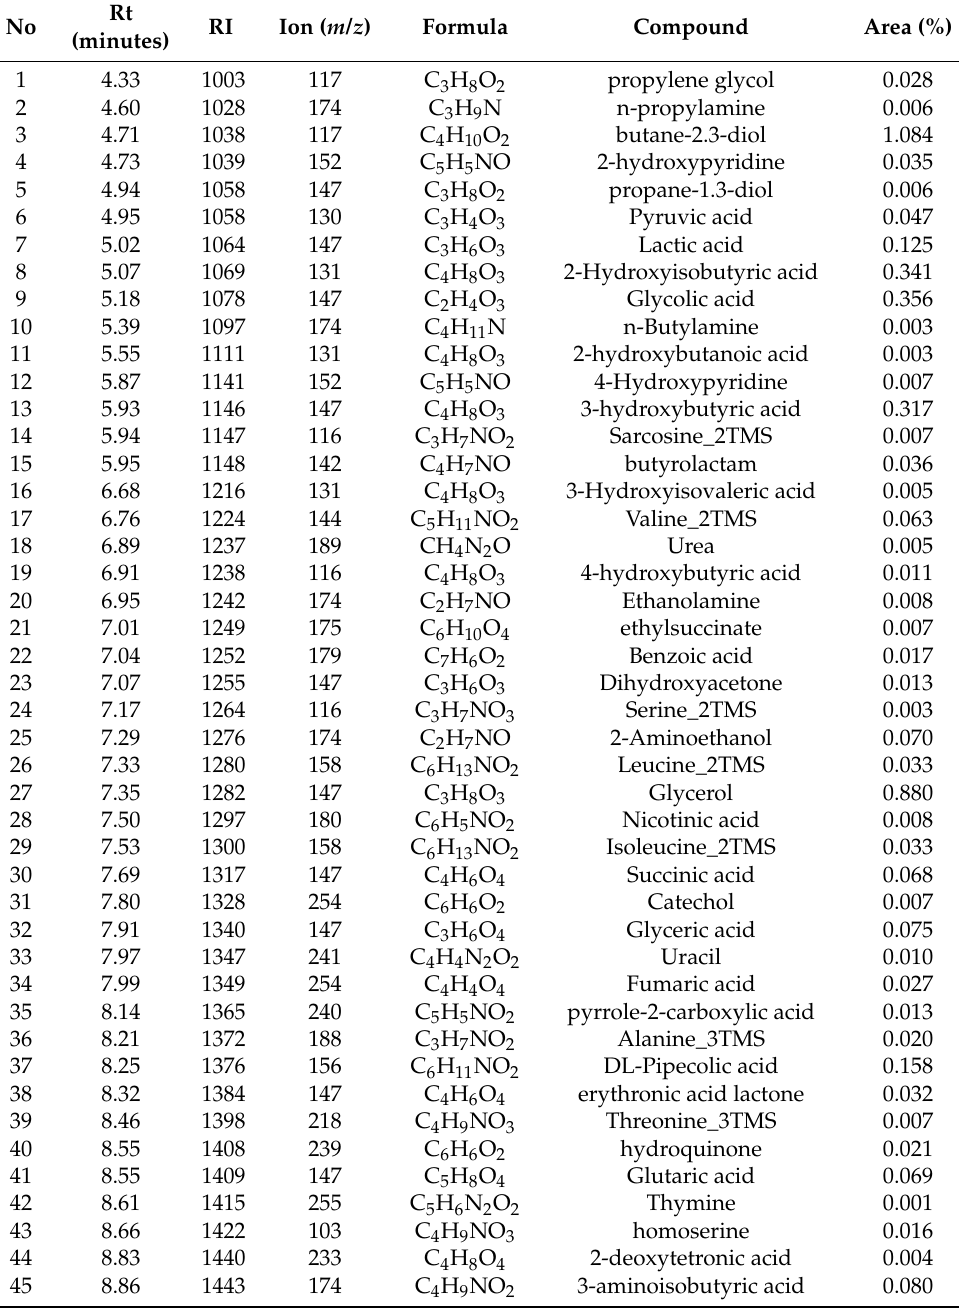
Table 2. Metabolites in the extract of X. granatum